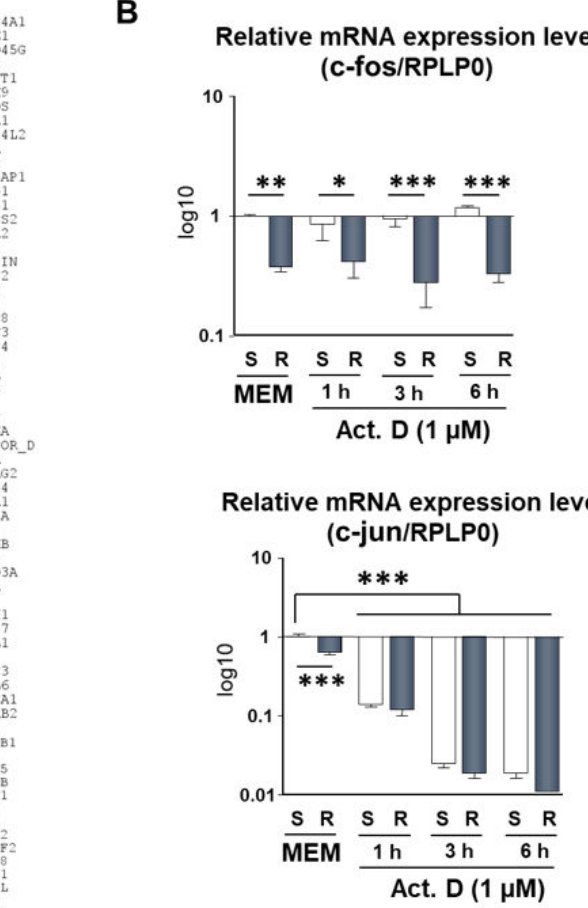
Figure 7. Microarray gene expression profile of HepG2 cells. ( A ) Hierarchical clustering analysis of the gene expression profiles of HepG2 cells corresponding to the following groups: MEM RNAi (IRS-4 mRNA levels were decreased by knockdown and maintained for 24 h in MEM); IGF-1 RNAi (IRS-4 mRNA levels were decreased by knockdown and maintained for 24 h in IGF-1 (25 nM)); IGF-1 scramble (mRNA levels from HepG2 cells treated with scrambled oligos and maintained for 24 h in IGF-1 (25 nM)). The expression levels of the mRNA from the three groups were compared with the control (mRNA levels from HepG2 cells treated with scrambled oligos and maintained for 24 h in MEM). The experiment is representative of two others with similar results. ( B ) Relative mRNA expression levels of c-fos and c-jun obtained by a qPCR in the HepG2 cells in which IRS-4 mRNA levels were decreased by knockdown (R) or were treated with scrambled oligos (S). HepG2 cells were maintained in MEM or in the presence of ActD (1 µ M) for 1, 3, or 6 h. RPLP0 was used as control of expression. Significance levels: * p < 0.05; ** p < 0.01; *** p <